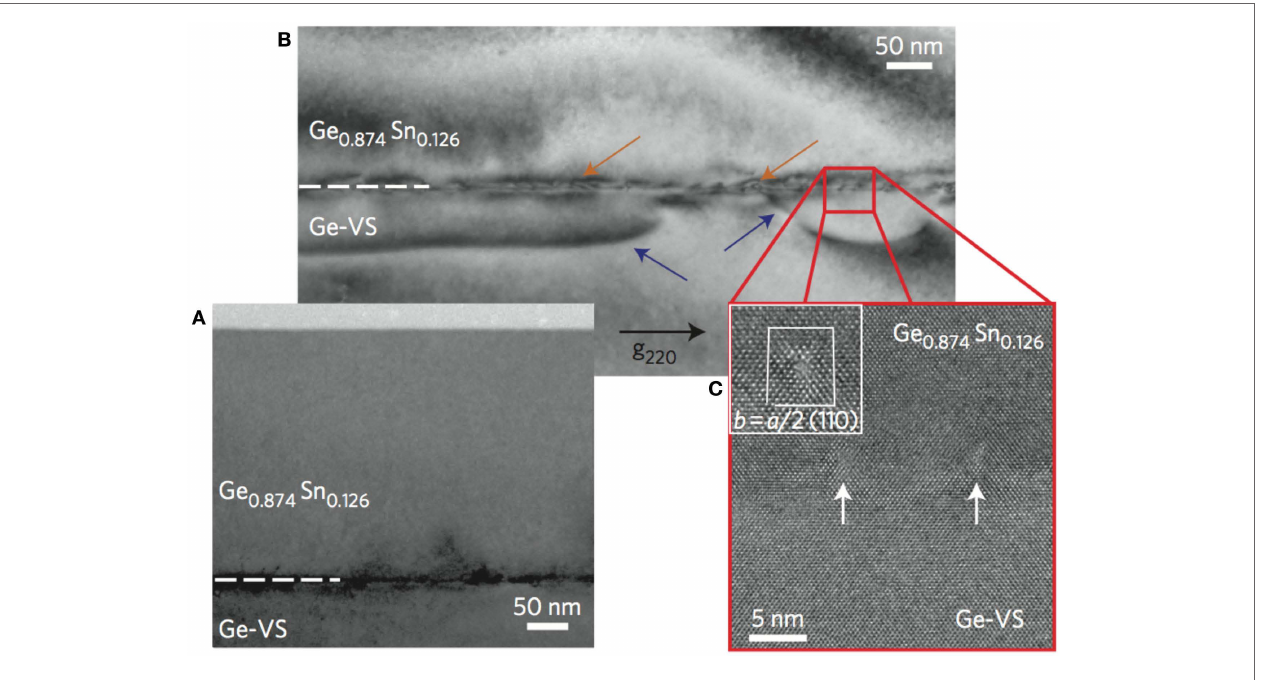
GeSn/Ge-interface (orange arrows) penetrating only into the Ge virtual substrate. (C) High-resolution TEM image of the interface used for Burgers vector calculations. Lomer dislocations with b = a /2[110] are observed (Wirths et al.,